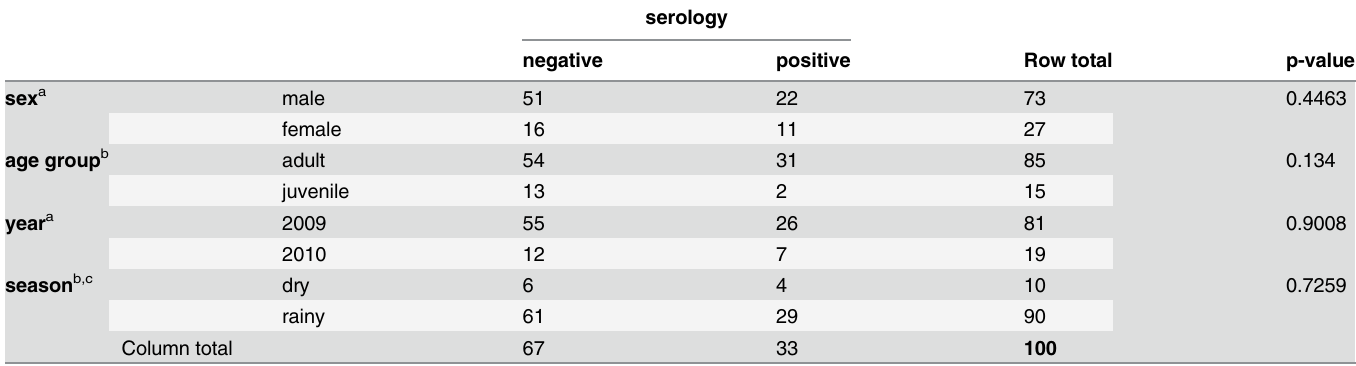
Table 2. Serological findings versus sex, age group, sampling year and —